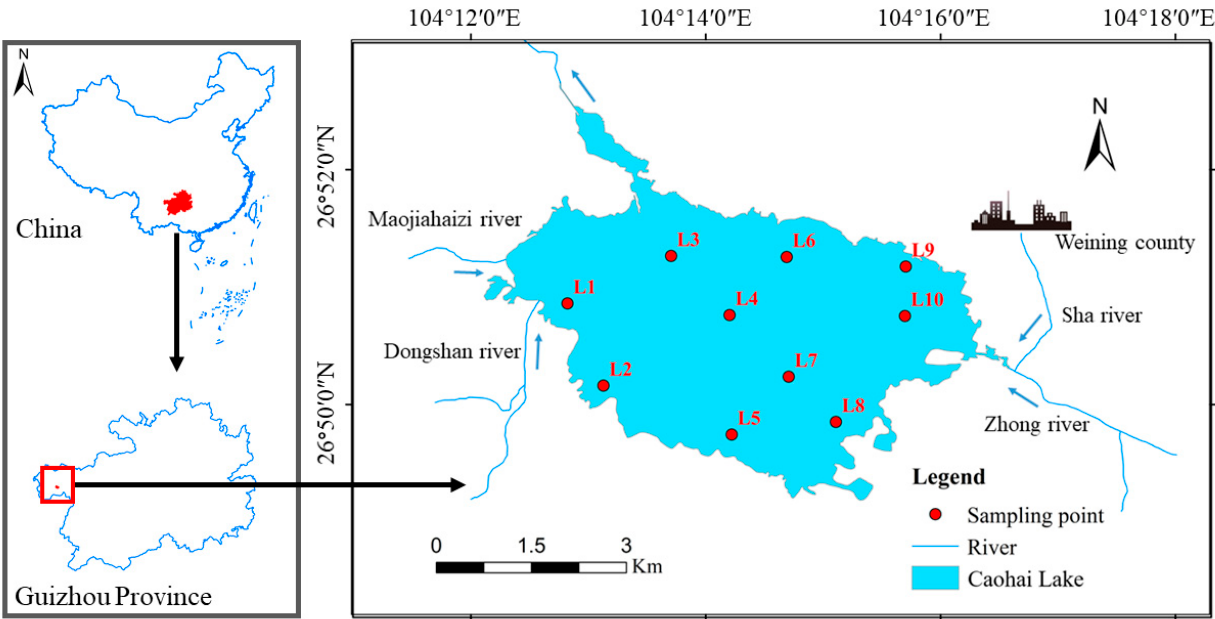
Figure 1. Distribution of sampling sites in Caohai Lake. Their positions were marked in red in the inserted maps of China and Guizhou Province.